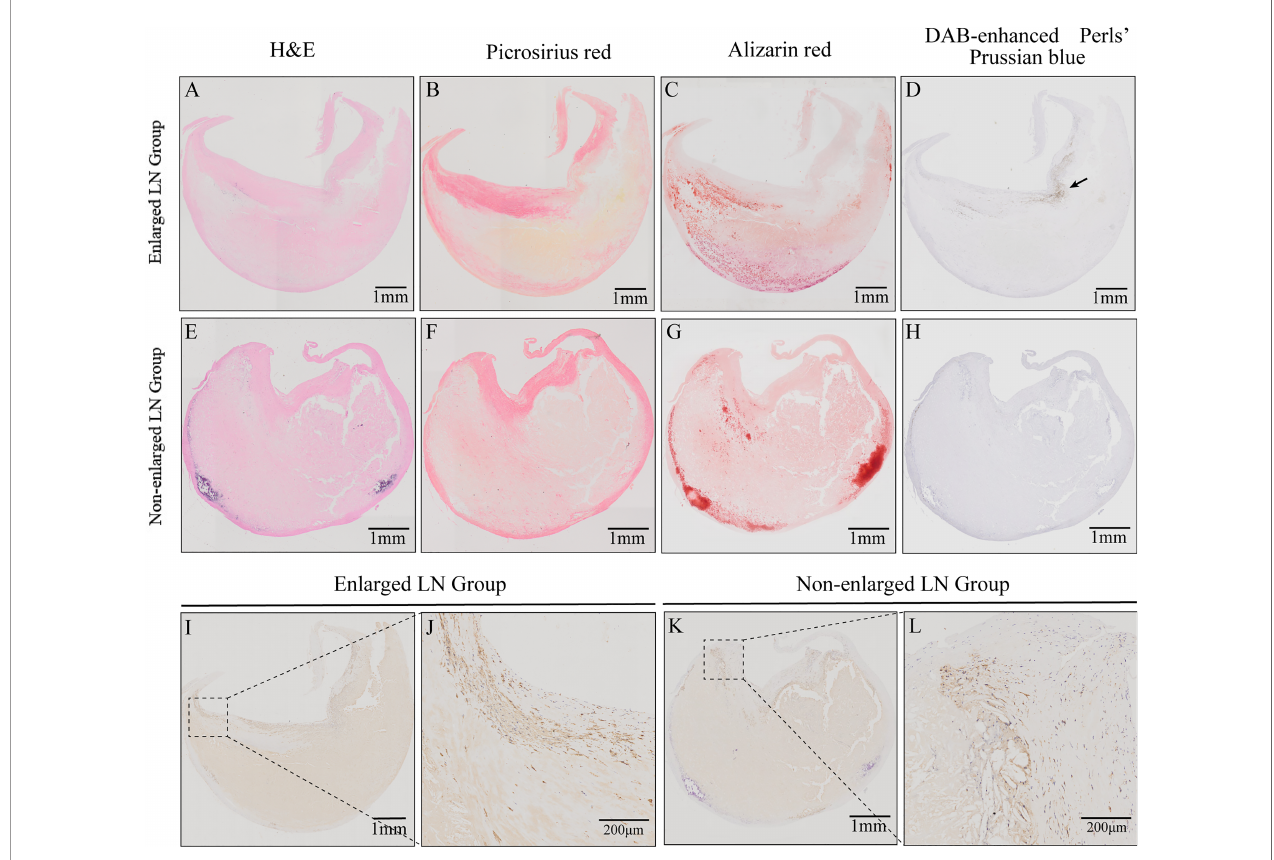
FIGURE 2 | Histological characteristics of carotid atherosclerotic plaques from patients with enlarged or non-enlarged lymph nodes (LNs). (A, E) Hematoxylin and eosin (H&E) staining. (B, F) Relative content of collagen fi bers and thickness of fi ber cap. (C, G) Relative content of calci fi cation and calcium morphology. (D, H) Intraplaque hemorrhage (arrow). (I – L) Immunohistochemistry (IHC) staining revealed macrophages and their in fi ltration in the shoulder